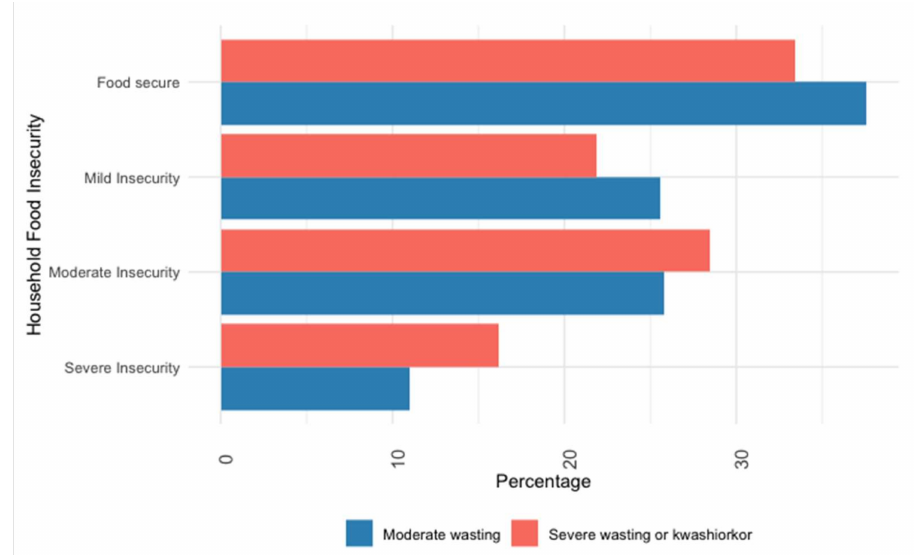
Figure 2. Distribution of food insecurity by nutritional status.